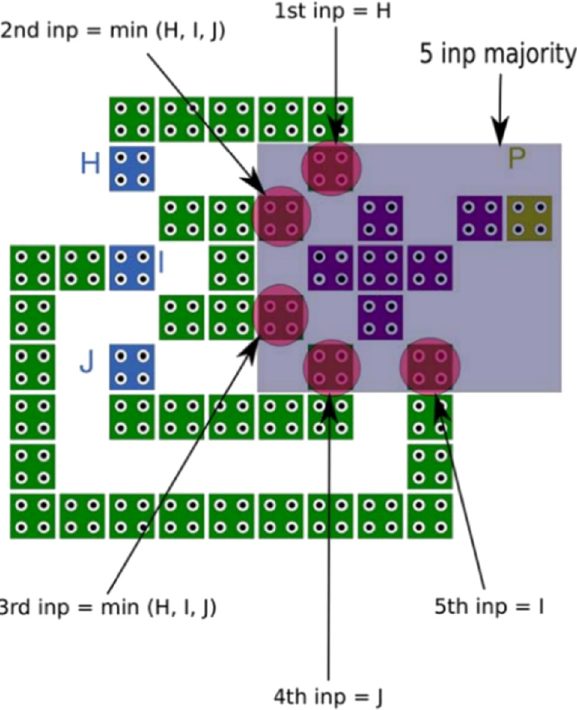
Figure 9: Di ff erent structures of 2 - input XOR gate proposed in ref. [ 11 ]